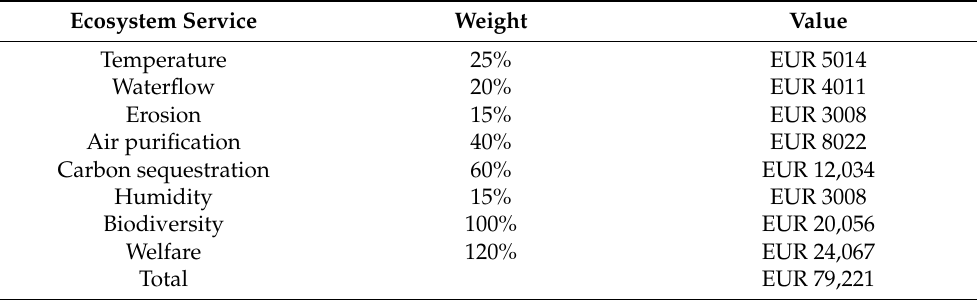
Table 5. New maximum contribution of ecosystem services per ha according to EU ETS Phase 4, including welfare.